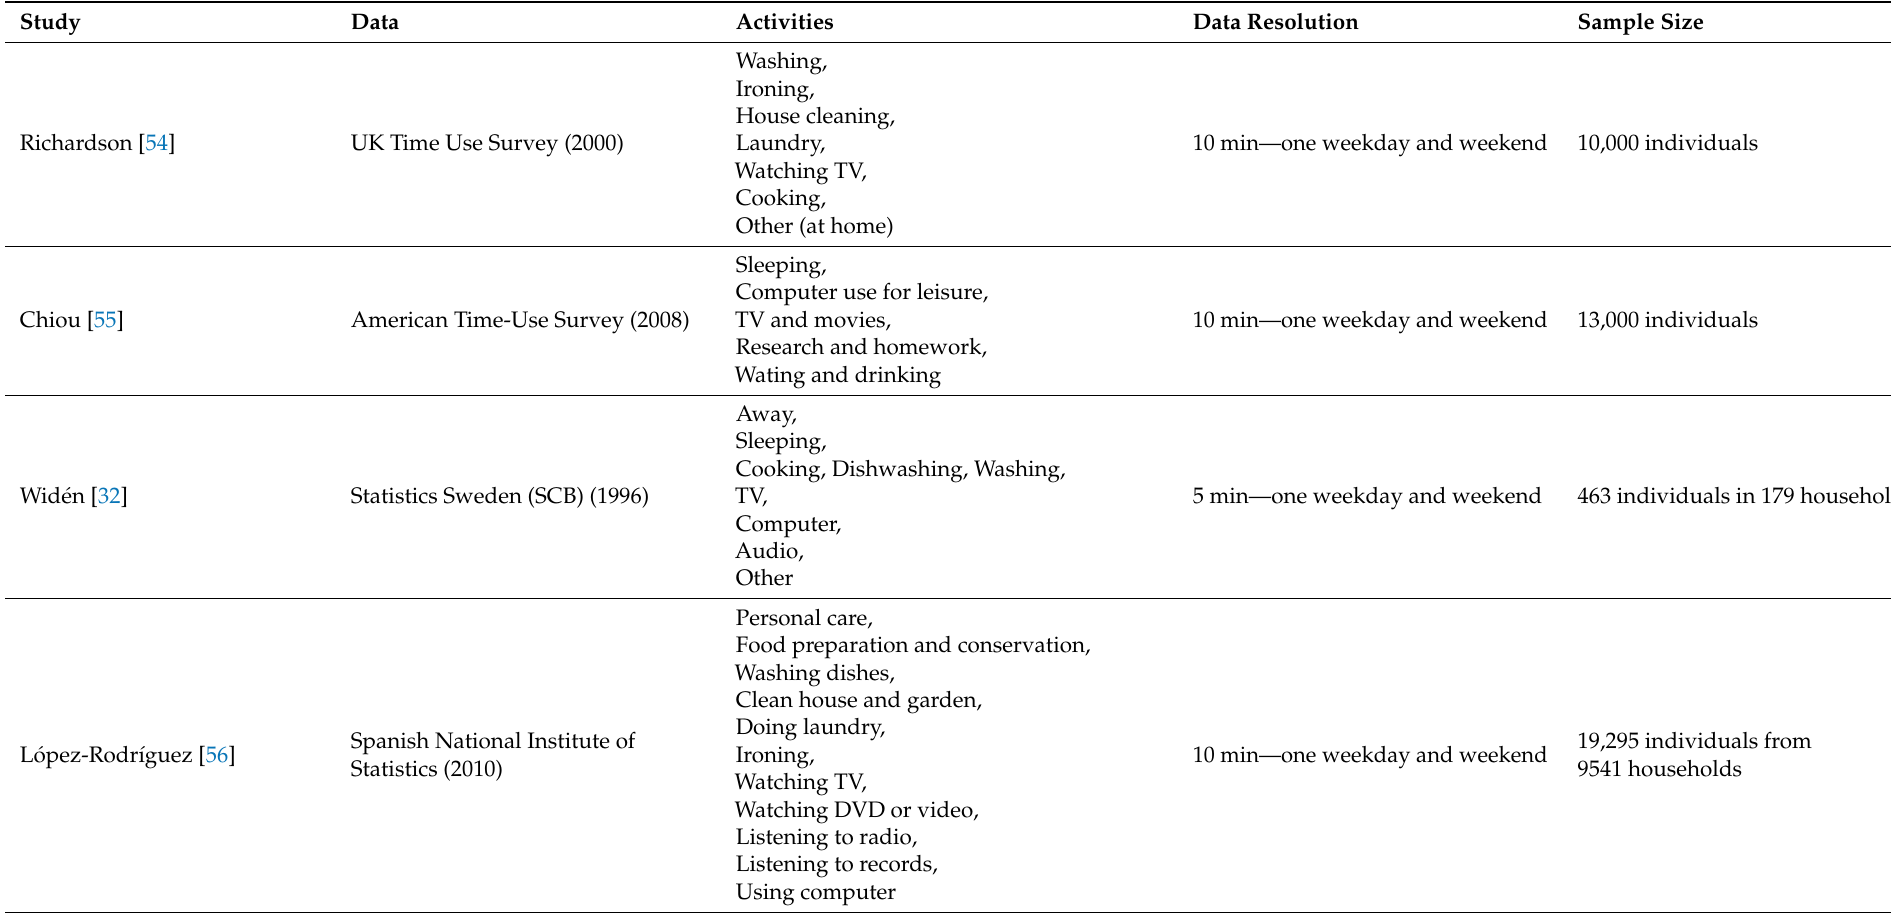
Table A3. Studies that employed time-use survey data in occupant behaviour-related building energy